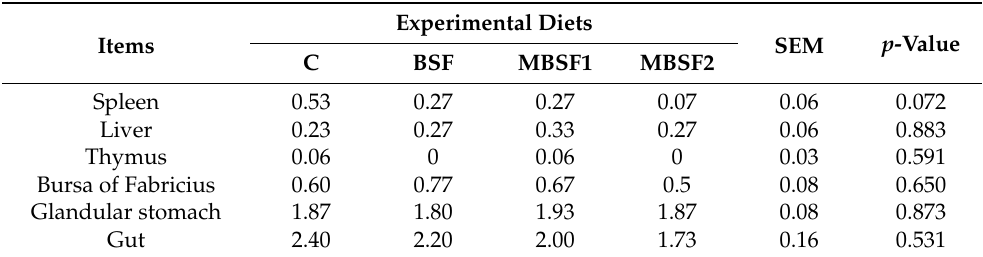
Table 9. Effects of dietary BSF larvae fat inclusion on the histopathological scores of the broiler chickens (n = 15/treatment).